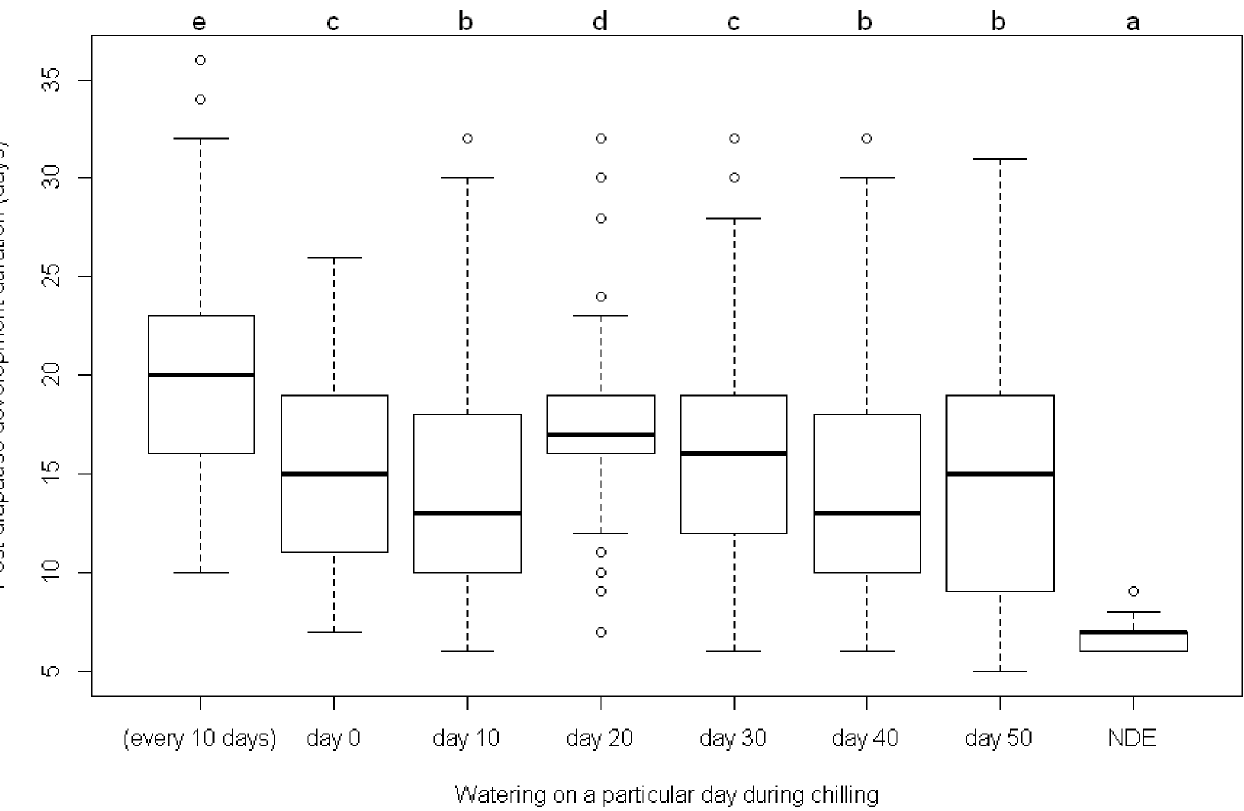
Fig 4. The post-diapause development duration of A . lucorum eggs with different water treatments during chilling at 4°C. NDE represents the developmental duration of non-diapause eggs. The different lowercase letters above each box indicated significant differences at the probability level of